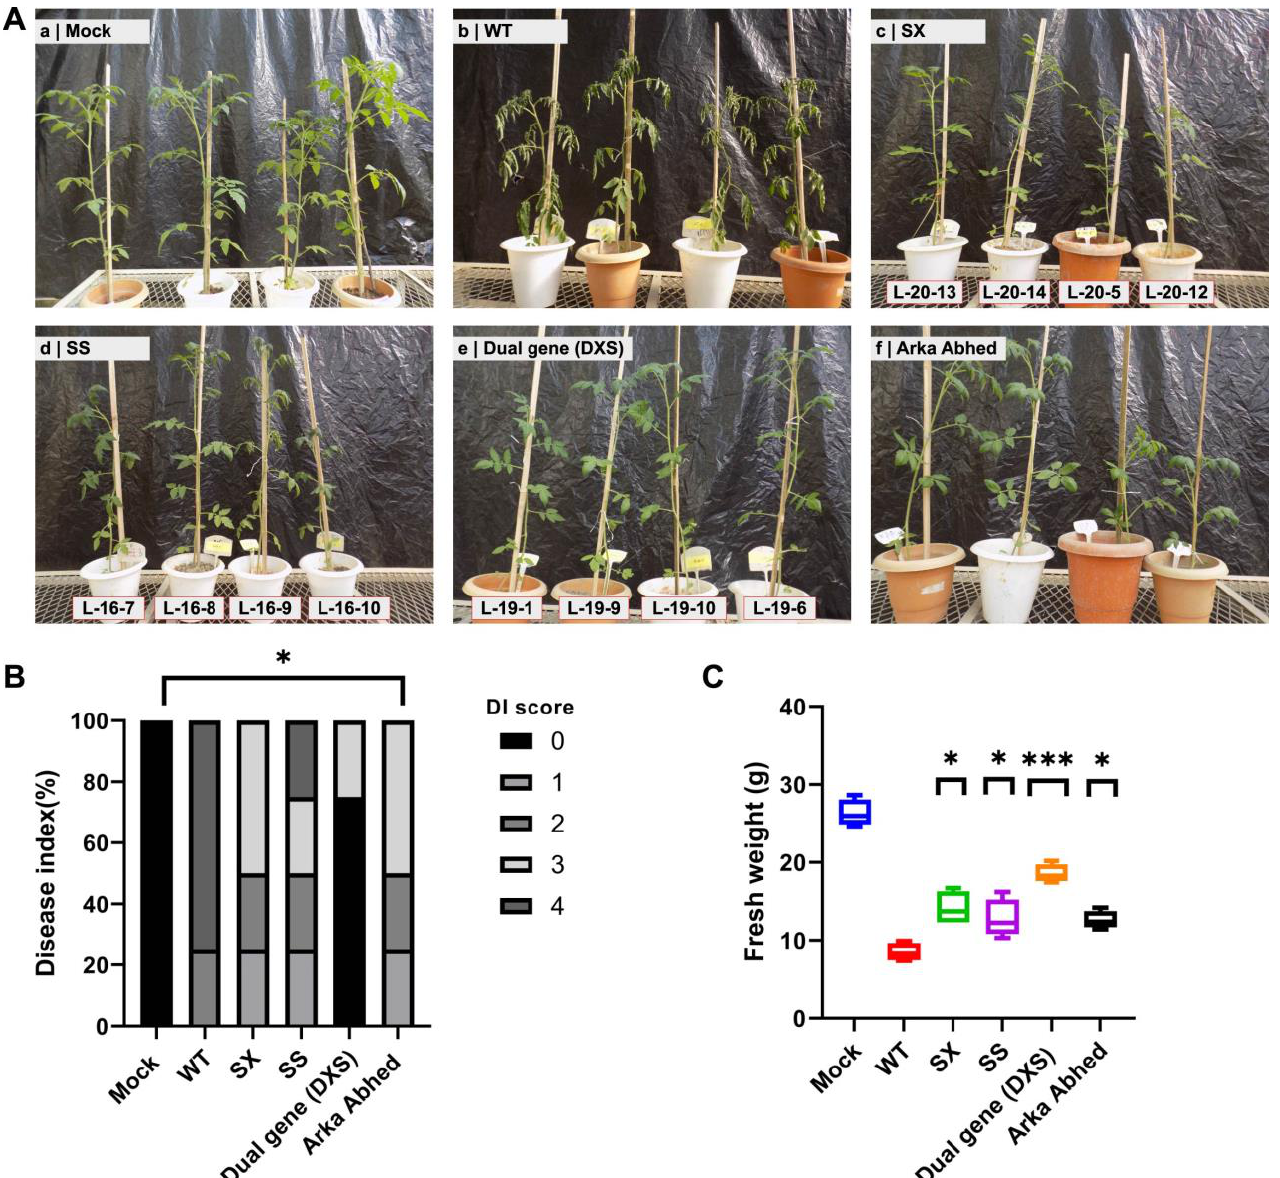
Figure 5. Phenotypic evaluation of single and dual-gene CRISPR-edited lines showing tolerance response upon Fol 1322 infection in 4-week-old tomato plants. ( A ) Four-weeks old plants of WT and CRELS inoculated with water (mock) and Fol 1322 after 21 days post-infection (PID). ( B ) Disease symptoms were scored by measuring the fresh weight above the cotyledon node and ( C ) disease index (0-4) of independent 4 plants/treatment. Plant fresh weight (FW) was subjected to a pairwise comparison Students t -test, whereas disease index was determined by non-parametric Kruskal–Wallis test (* p < 0.05, ** p < 0.01, *** p < 0.001).